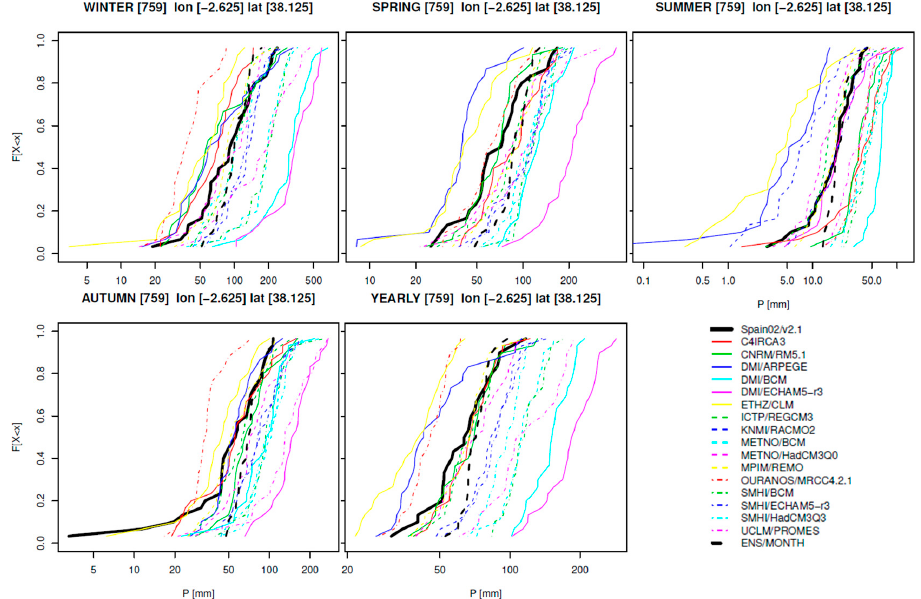
Figure 5. Seasonal and yearly rainfall Cumulative Density Functions (CDFs) on site 759, located in the Fuensanta Basin, from observational dataset (in black), RCMs (in color) and RCMs ensembles (black dashed black), for the 1961–1990 period.